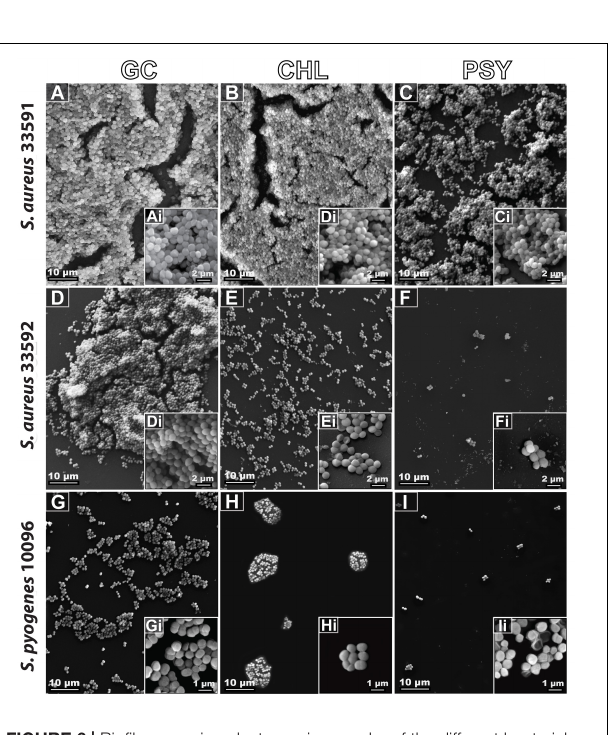
FIGURE 6 | Biofilm scanning electron micrographs of the different bacterial strains with or without antimicrobial treatment. GC, growth control (A,D,G) ; CHL, chloramphenicol (B,E,H) ; PSY, psychorubrin (C,F,I) . Note in high magnification (inset), the morphological external structure of the different bacterial